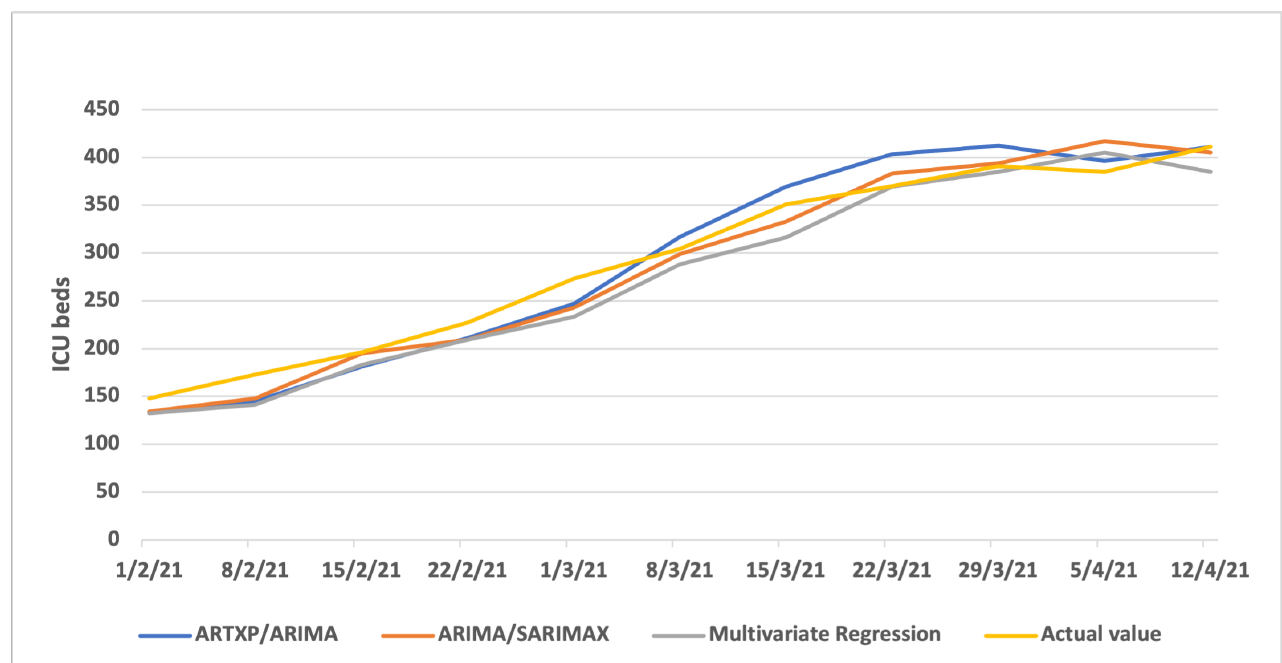
Figure A9. Three weeks Predicted vs. Actual ICUs—Greece. Figure A10 (one week ahead), Figure A11 (three weeks ahead) and Figure A12 (three weeks ahead) showcase the results per model (ARTXP/ARIMA, ARIMA/SARIMAX and Multivariate Regression) of Predicted vs. Actual ICUs for the Attica area.